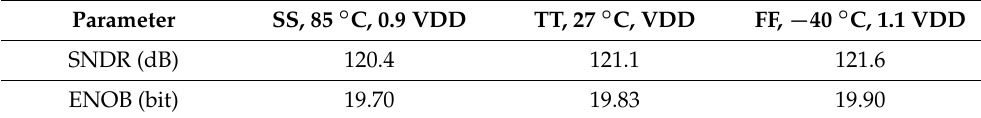
Table 1. PVT simulation results at − 1.1 dBFS input level and F s = 200 kHz.